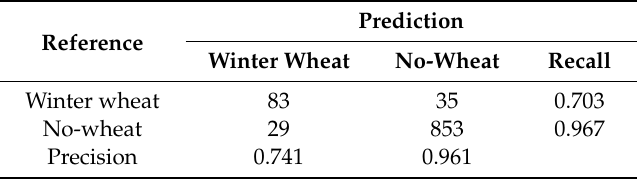
Table 8. Confusion matrix of the prediction map informed by Table 7. Confusion matrix of the prediction map informed by A-LSTM.